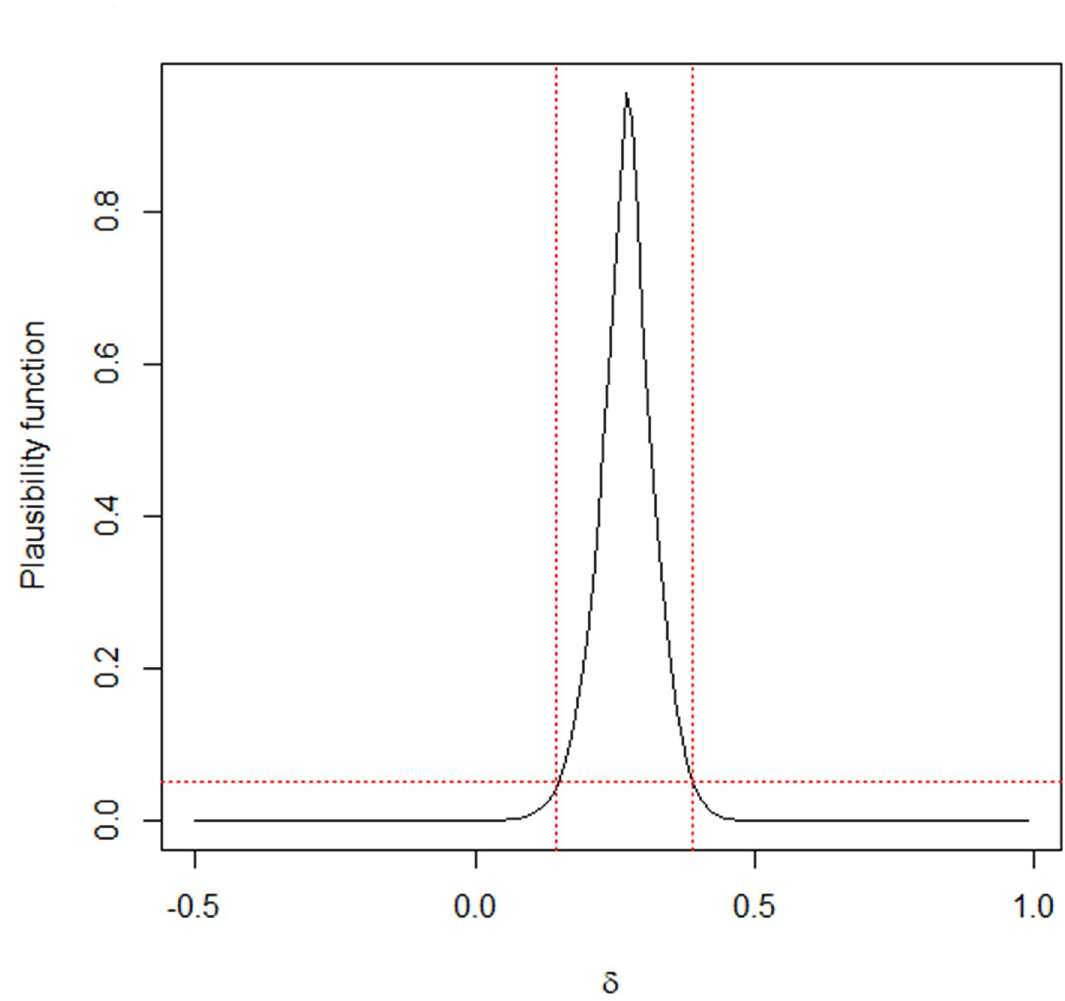
Fig 10. MIM’s Plausibility function of δ in the calf immunity